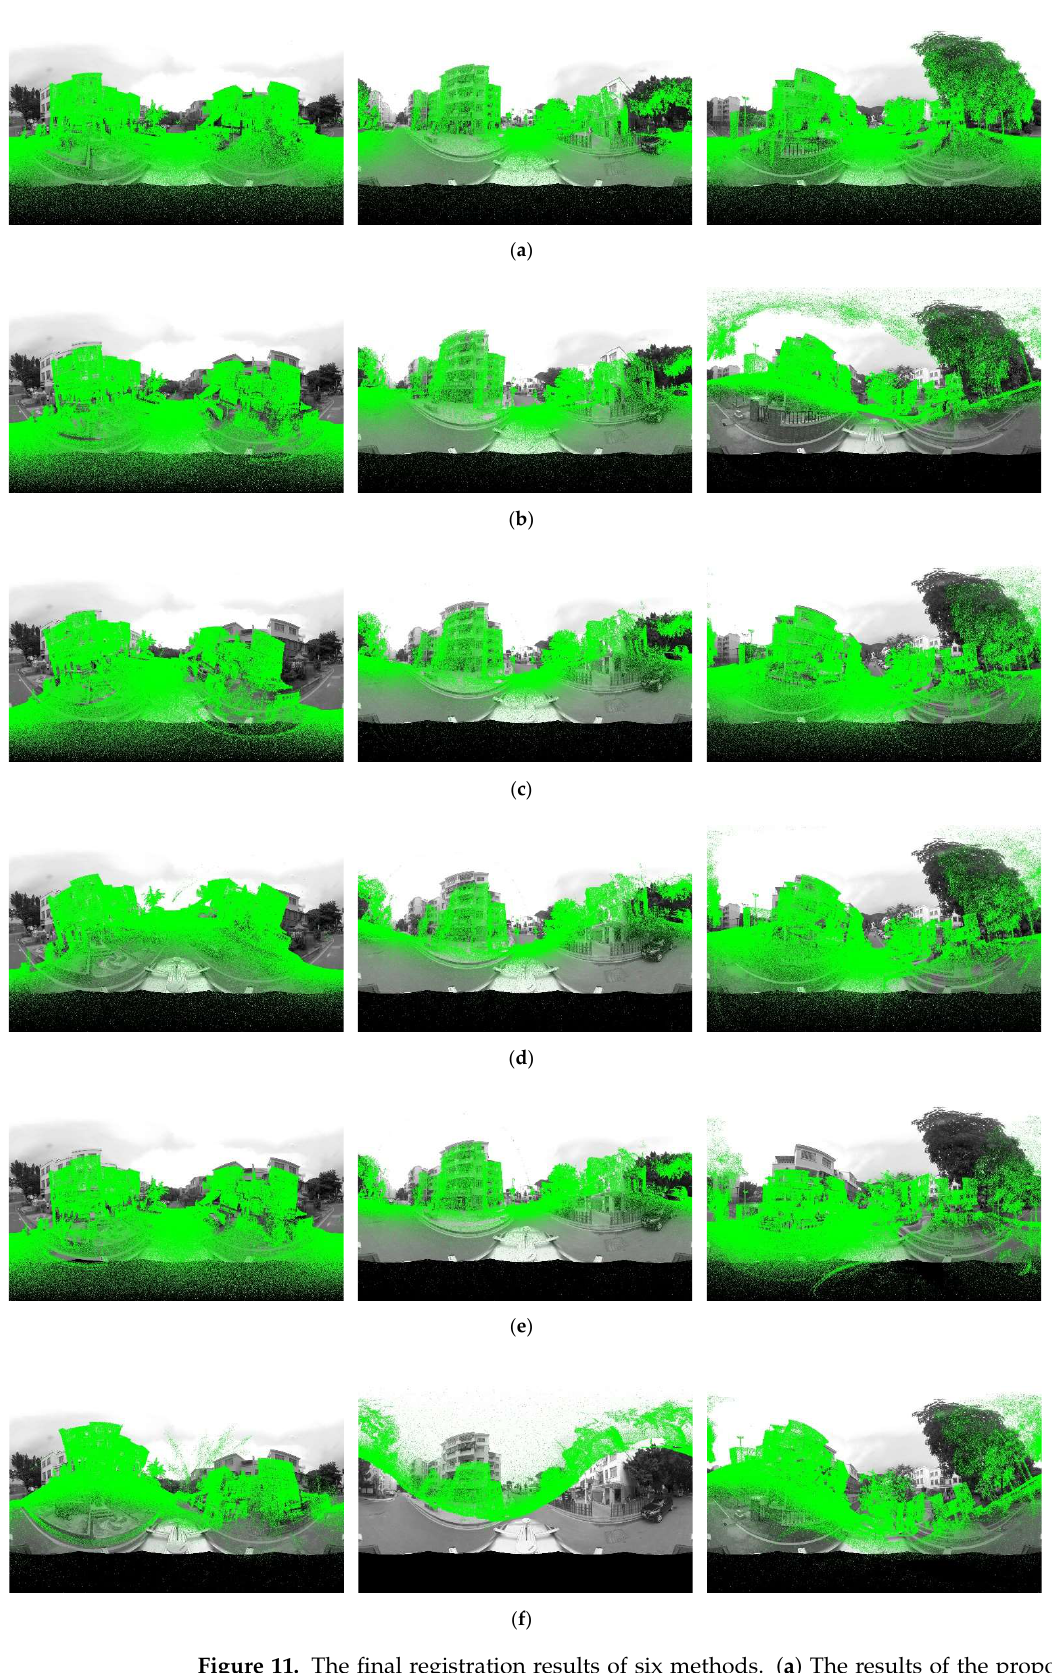
Figure 11. The final registration results of six methods. ( a ) The results of the proposed method; ( b ) the results of RIFT; ( c ) the results of MI; ( d ) the results of PSO-SIFT; ( e ) the results of 3MRS; and ( f ) the results of SIFT.